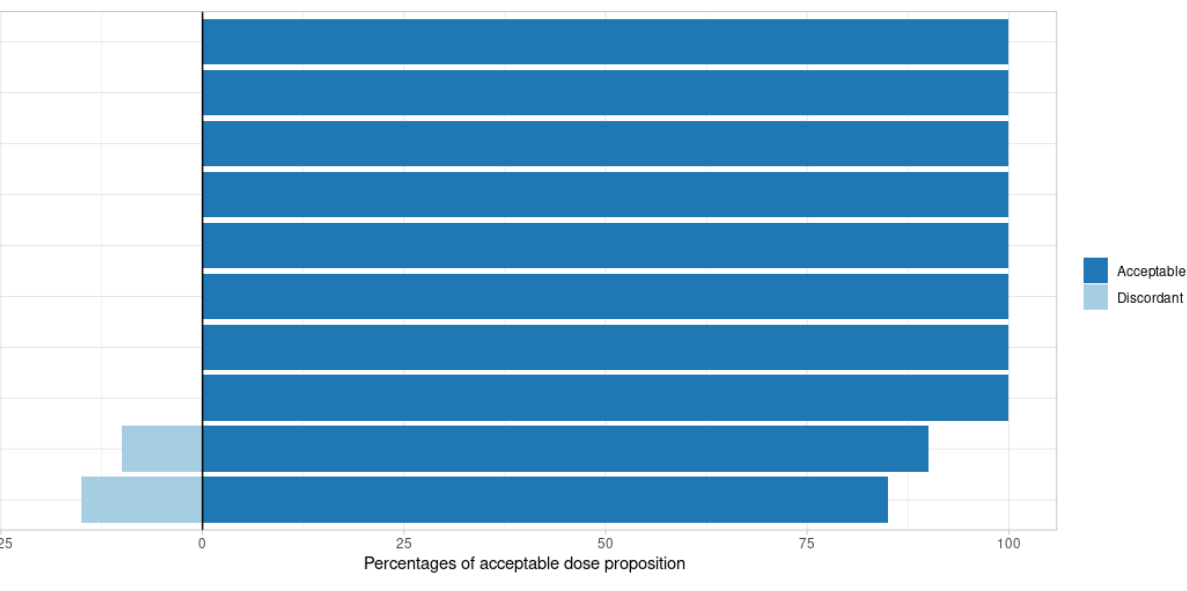
Figure 2. Adequacy of dose adaptation by tested model for a target AUC based on SIR posterior estimates. The negative percentages are the proportions of discordant propositions.